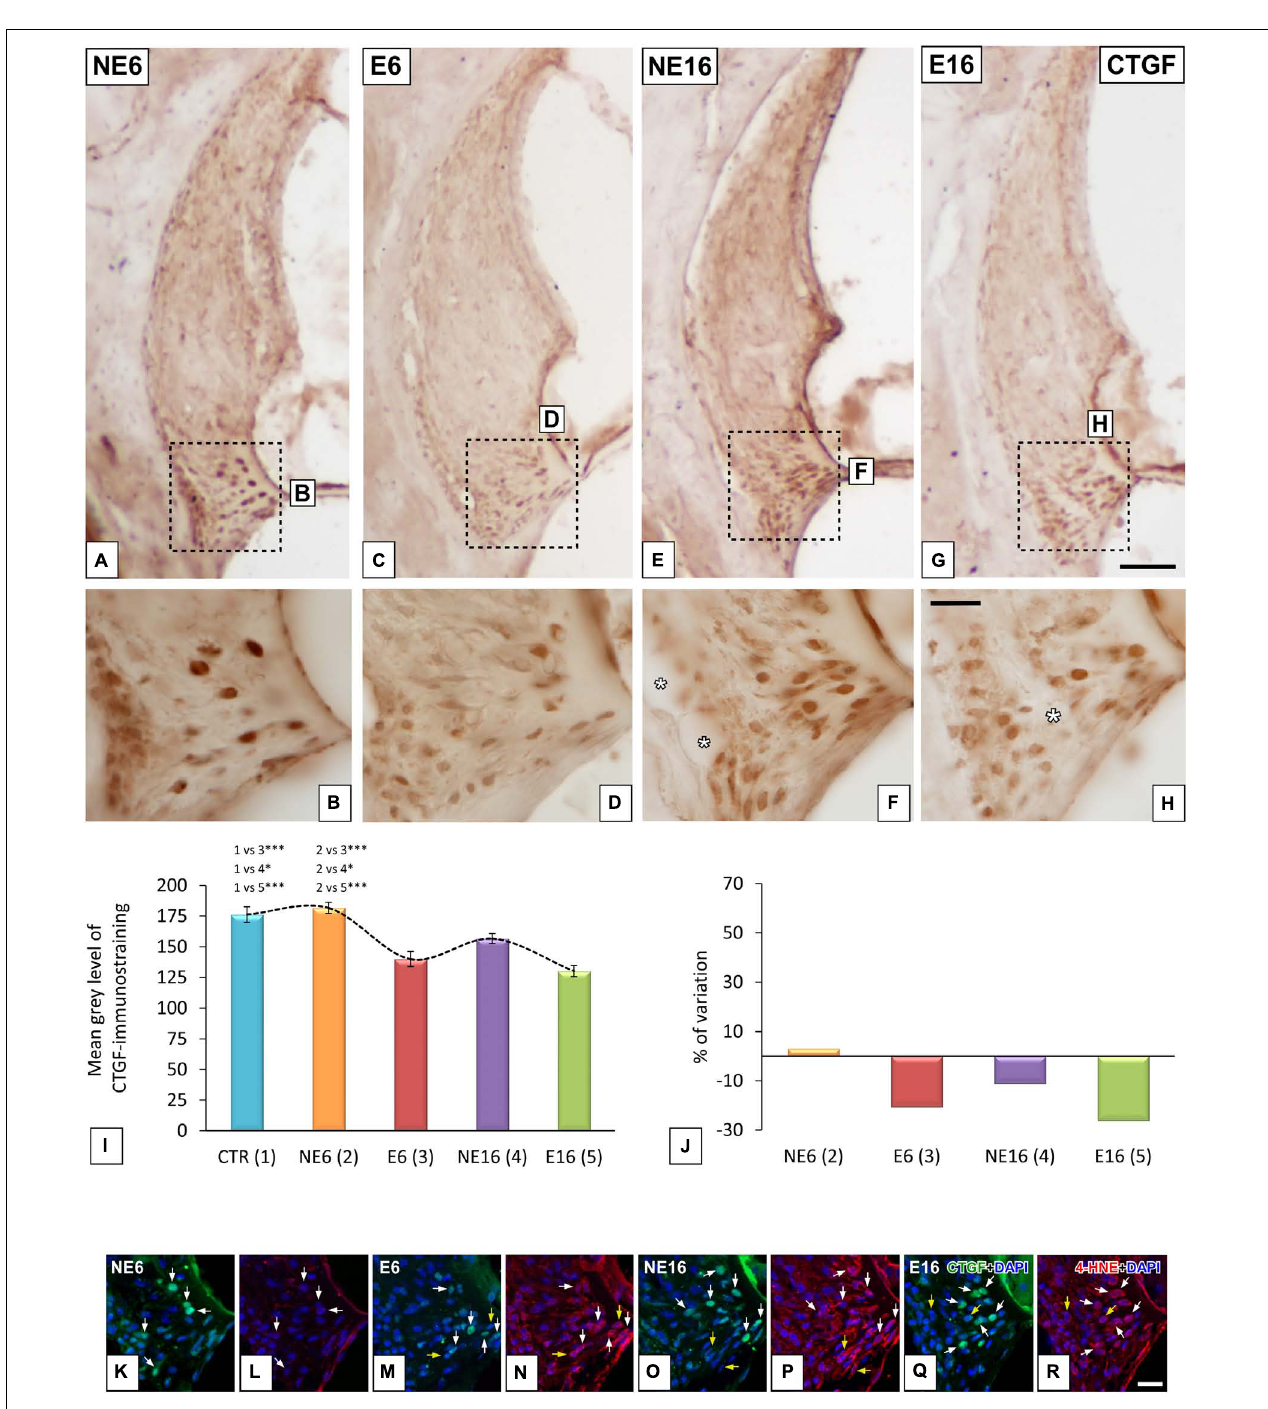
FIGURE 5 | Digital images illustrating CTGF-immunostained type IV fibrocytes in the spiral ligaments of young/adult and aging rats exposed to NAP. NAP-exposure in E6 (C,D) and E16 (J,G,H) rats resulted in decreased CTGF staining relative to unexposed control rats (A,B) . Note, however, that in the aging unexposed group (E,F) these levels were increased relative to the E6 and E16 groups. The quantification of the immunostaining corroborated these qualitative results (I,J) . Double immunohistochemical staining for CTGF (green) and 4HNE (red) in the spiral ligaments of E6, NE16, and E16 rats showed that all CTGF-stained fibrocytes expressed 4-HNE (white arrows in M–R ) compared to unexposed rats (white arrows in K,L ). Dashed square boxes in (A,C,E,G) denote the approximate locations of the higher-magnification images shown for each group. Yellow arrows point to 4-HNE-stained fibrocytes that do not express CTGF. Asterisks in (F,H) indicate blood vessels. Cell nuclei (blue) were counterstained with DAPI. ∗ p < 0.05; ∗∗∗ p < 0.001. Scales bars: 100 µ m in (G) ; 20 µ m in (H,R) . n = 4 for each animal group.